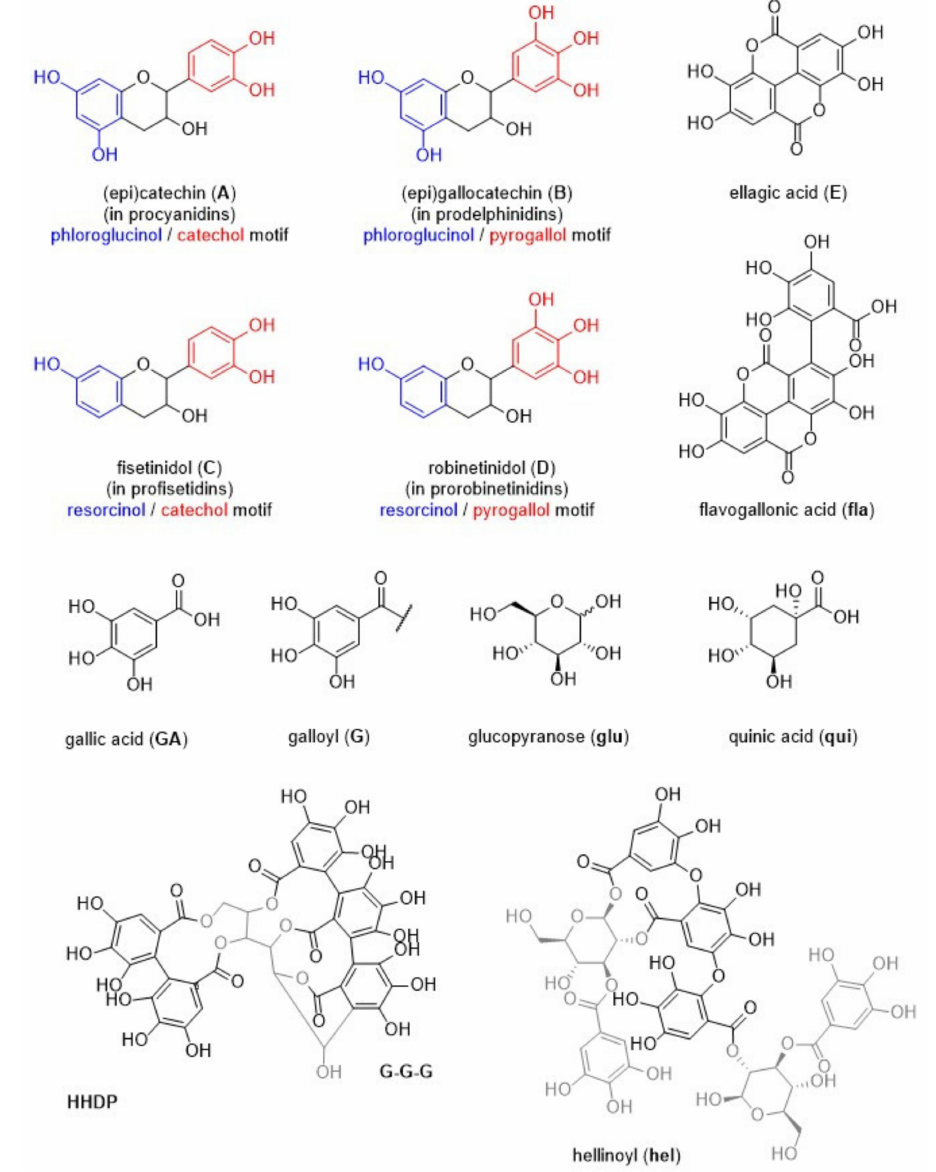
Figure 2. Structural elements used for discussing the various analysis data. Structures in grey are not